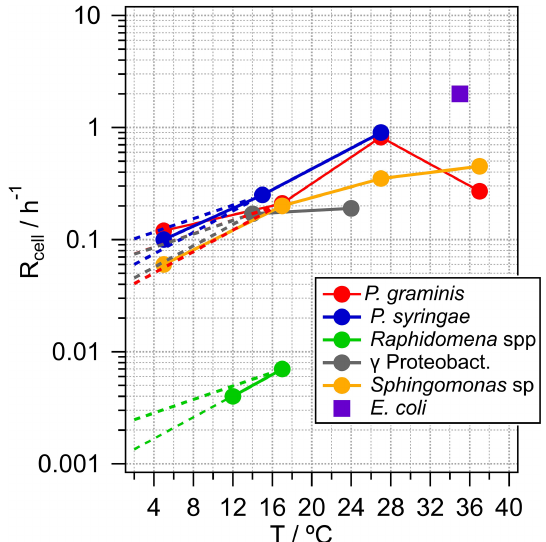
Figure 2. Temperature dependence of generation rates, R cell , for bacteria types representative of the ecosystems in Table 1 and E. coli as a likely upper limit for cell generation. Dashed lines are ex- trapolations of the rates at T ∼ 20 ◦ C using Q 10 = 2 or Q 10 =